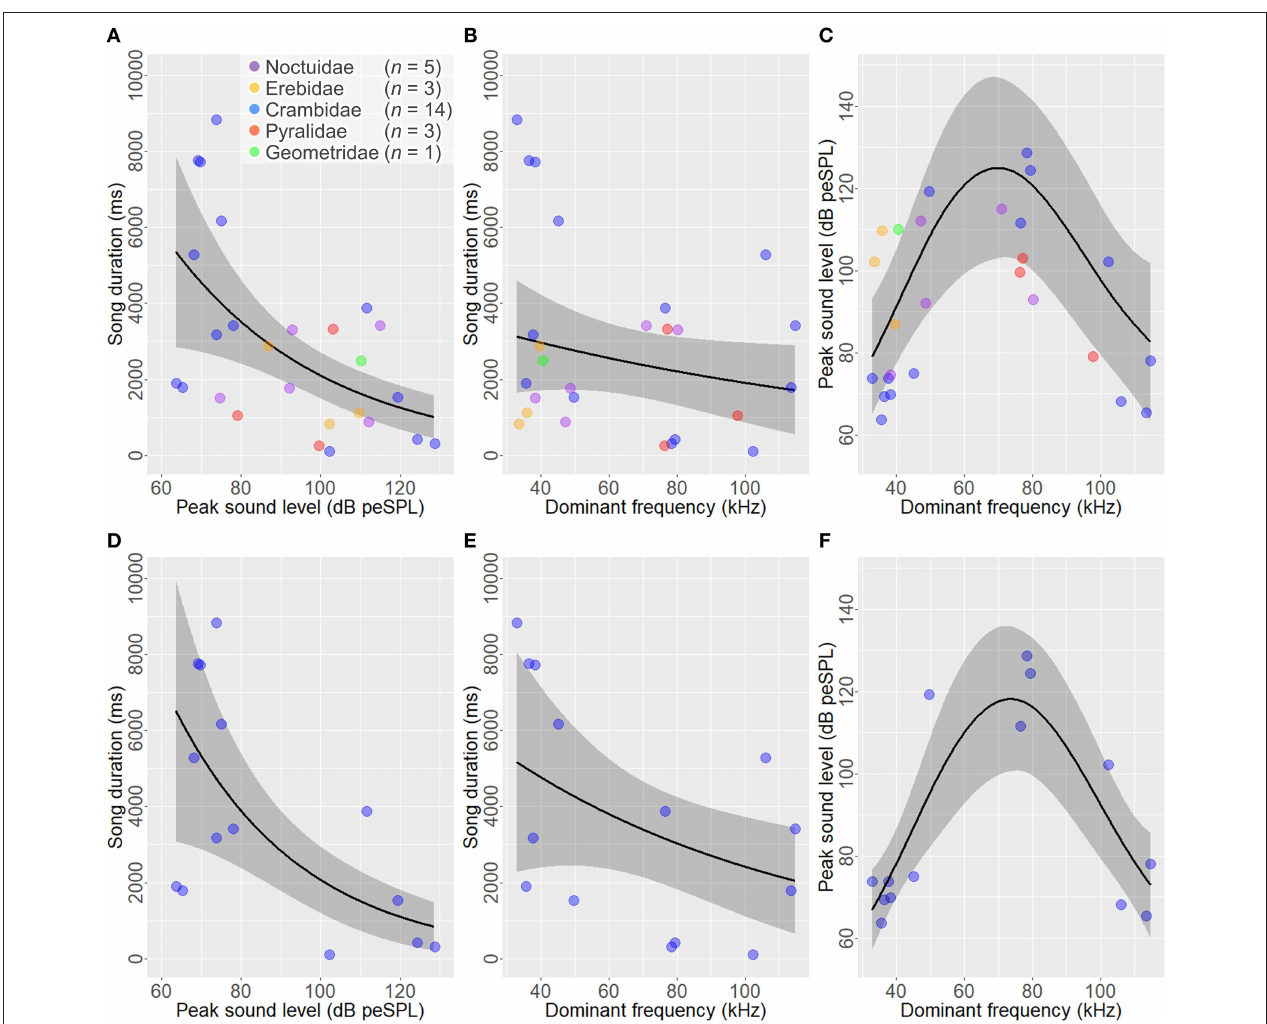
FIGURE 4 | Relationships among song duration, peak sound level, and dominant frequency in male ultrasonic courtship songs of moths. For the 26 moth species, there is a negative relationship between song duration and peak sound level (A) , whereas no relation is found between song duration and dominant frequency (B) . A significant nonlinear relationship is found between peak sound level and dominant frequency (C) . When considering only the 14 crambid moths, a negative relationship between song duration and peak sound level is prominent (D) , there is no relation between song duration and dominant frequency (E) , and a nonlinear relationship is significant between peak sound level and dominant frequency (F) . Black lines and gray bands are means and 95% confidence intervals estimated by GAMM. Colored circles are means for each species; purple, Noctuidae (Noctuoidea); orange, Erebidae (Noctuoidea); blue, Crambidae (Pyraloidea); red, Pyralidae (Pyraloidea); green, Geometridae